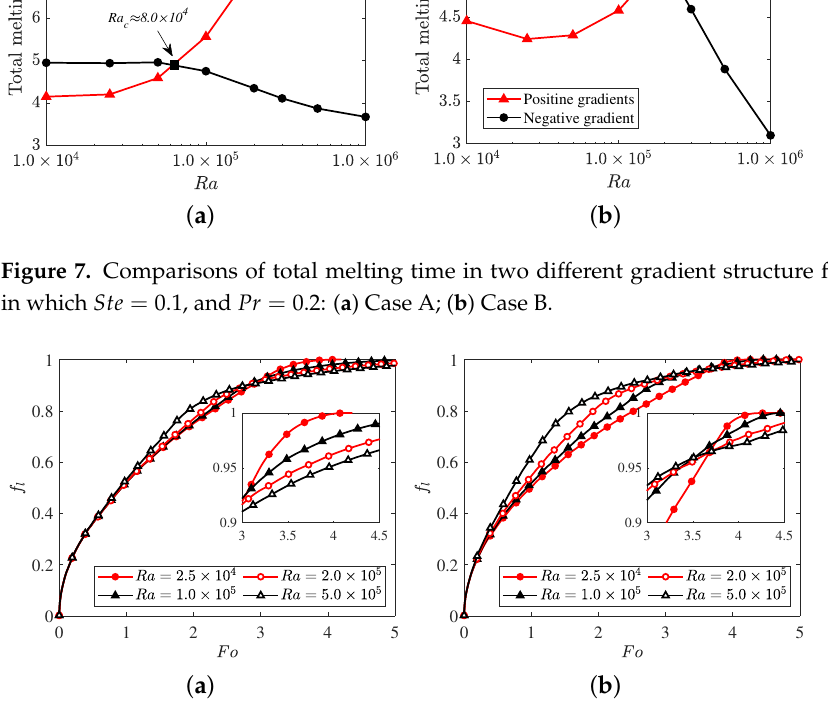
Figure 8. Comparisons of total melting time for positive gradient structure at different Ra , in which Ste = 0.1, and Pr = 0.2: ( a ) Case A; ( b ) Case